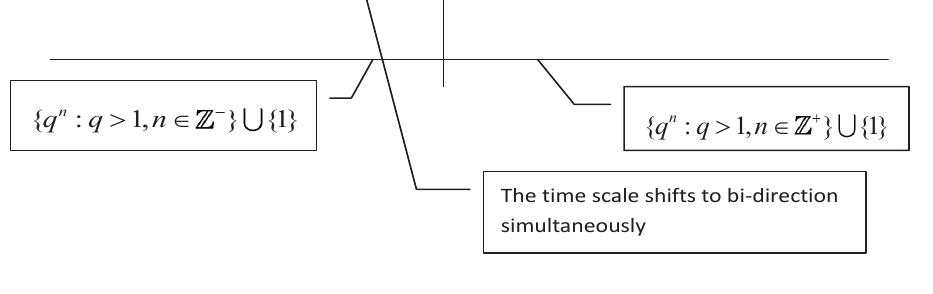
Figure 5. The time scale T = q Z has the characteristic point e Π ∗ = 1 at which the shift δ τ ( · ) is continuous. This time scale has the bidirectional shift